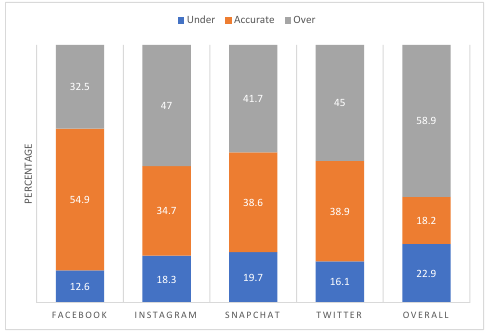
Figure 3. Percentages of students under-reporting, accurately reporting, and over-reporting their social media use by platform and across all platforms among all participants. 3.4. Is Sex (H4) or # of SM Used (H5) Related to Likelihood of Over/Under-Estimation? Table 3 presents results from multinomial regression models examining the relative